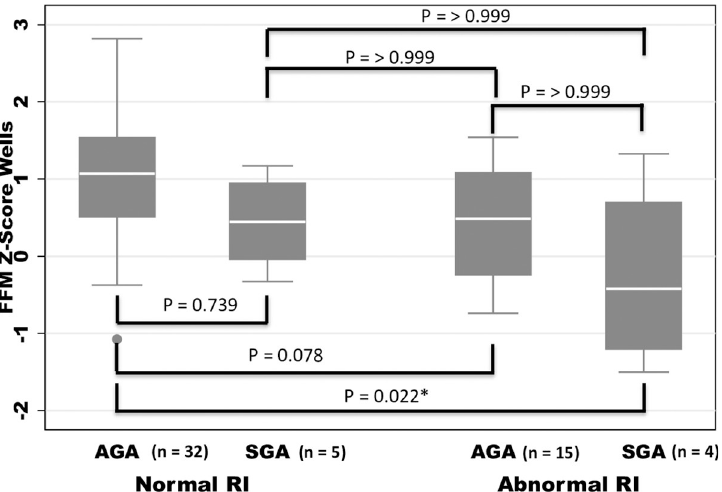
Fig 3. Fat-free mass Z-scores at age 6 months according to normal/abnormal RI and AGA/SGA classifications. � Denotes significant difference between groups. Abbreviations: FFM = fat-free mass; AGA = appropriate-for- gestational age weight at birth; SGA = small-for-gestational age weight at birth; Normal RI = normal resistance index (of the umbilical artery Doppler); Abnormal RI = abnormal resistance